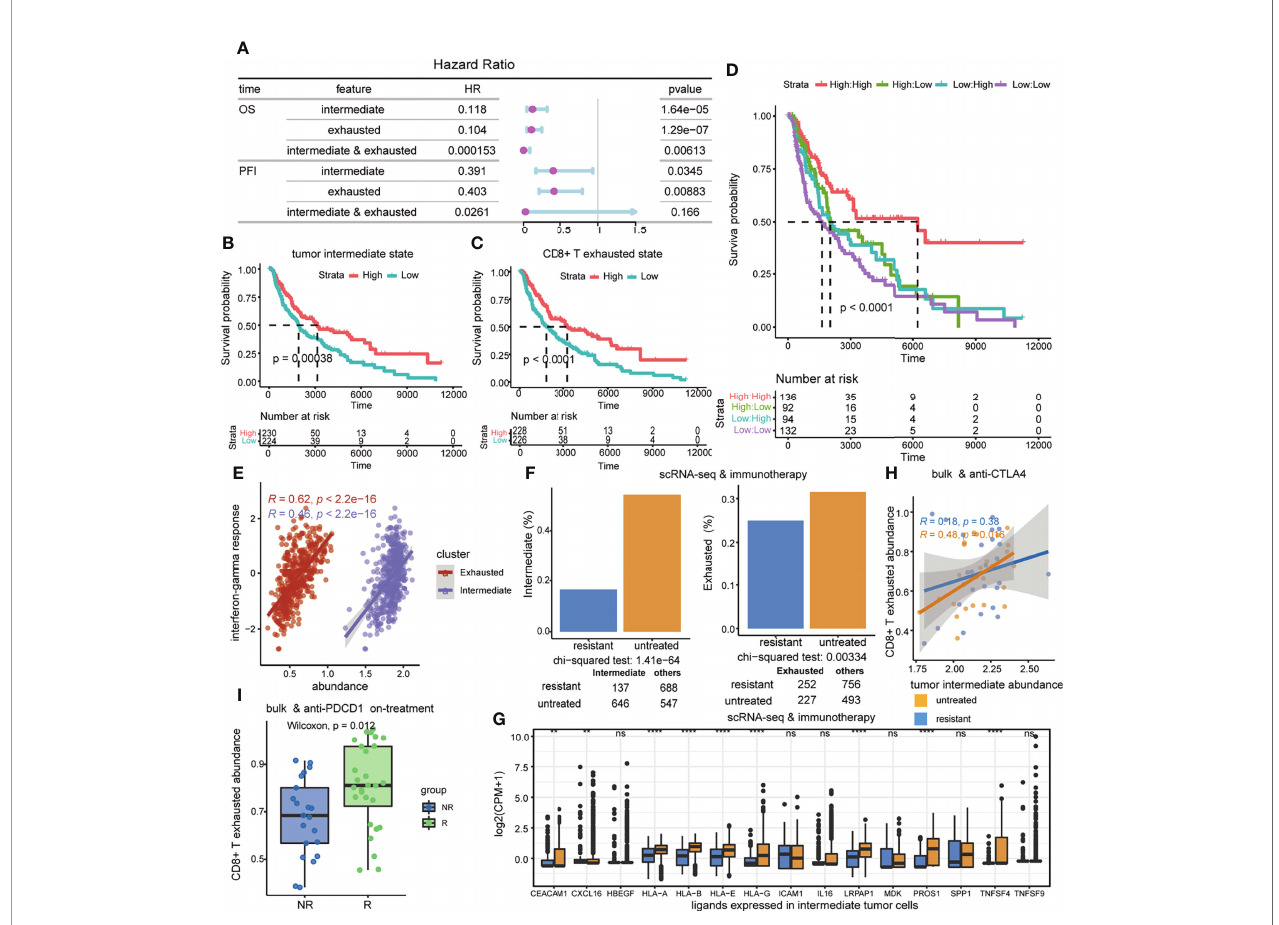
FIGURE 7 | The association of the tumor intermediate state and the CD8+ T exhausted state with clinical bene fi t. (A) Prognostic value of tumor intermediate state and CD8+ T exhausted state ssGSEA scores in the TCGA-SKCM cohort. Forest plots show HRs (purple circle) and 95% con fi dence intervals (horizontal ranges) derived from Cox regression survival analyses for overall survival and progression-free interval. (B – D) Kaplan – Meier survival curves of overall survival by tumor intermediate state ssGSEA score (B) , CD8+ T exhausted state ssGSEA score (C) , and the combination of those two score variables (D) in the TCGA-SKCM cohort. (E) Correlations of interferon-gamma response scores with tumor intermediate state ssGSEA scores as well as CD8+ T exhausted state ssGSEA scores. (F) The difference in the proportion of intermediate tumor cells and exhausted CD8+ T cells between immunotherapy untreated and resistant samples in the scRNA-seq dataset. (G) The difference in the expression level of shared ligands in intermediate tumor cells between immunotherapy untreated and resistant samples in the scRNA-seq dataset. (H) The correlations of the tumor intermediate state with the CD8+ T exhausted state, which are compared between anti-CTLA4 untreated and progressed samples in the GSE91061 cohort. (I) Comparison of CD8+ T exhausted state activities between responder and non-responder patients who were on anti-PDCD1 treatment in the GSE91061